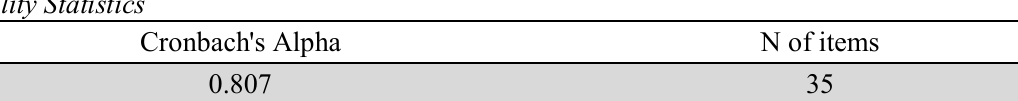
Reliability Statistics